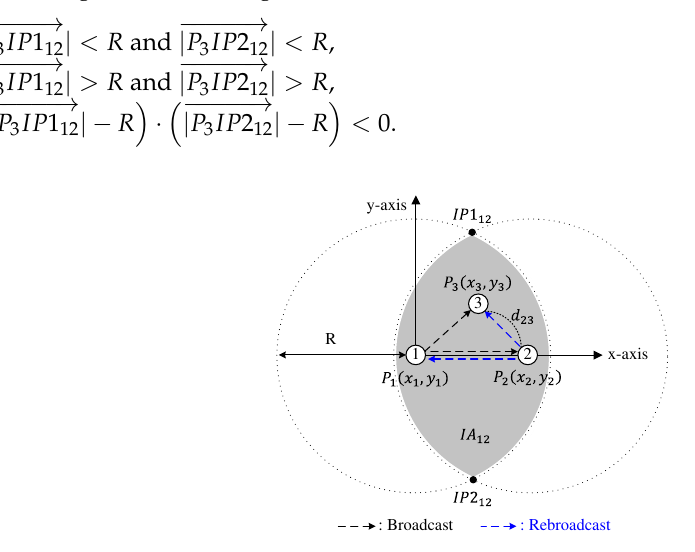
Figure 5. Nodes in the shadowed area receive the same broadcast-message from nodes 1 and 2.